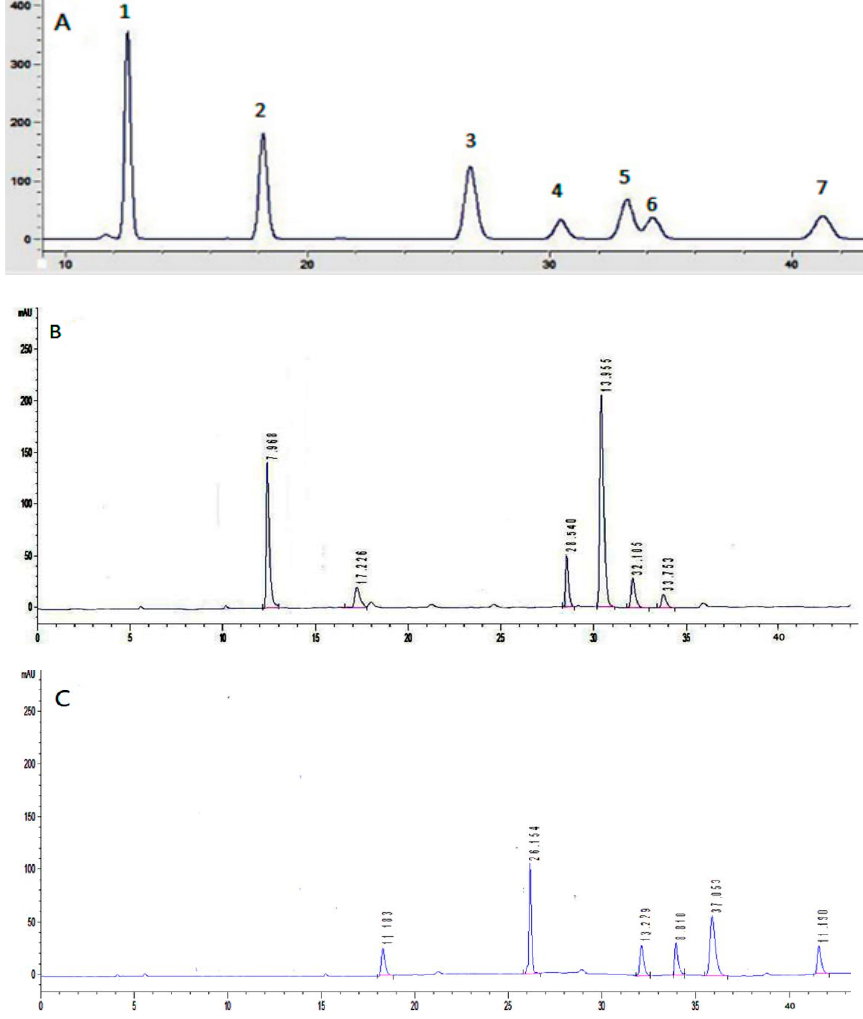
Figure 2. Chromatograms of monosaccharides compositions: ( A ) seven monosaccharides (1: mannose, 2: rhamnose, 3: glucose, 4: galactose, 5: xylose, 6: arabinose, 7: fucose); ( B ) IOEP1; ( C ) IOEP2.